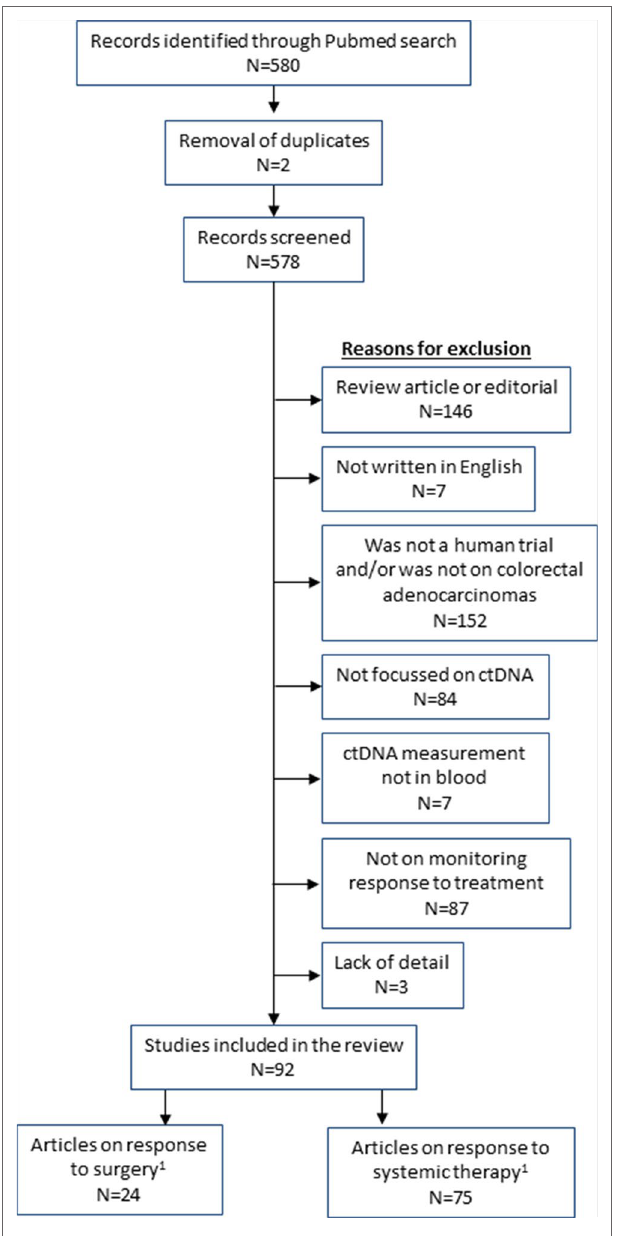
FiGURe 2 | Some of the different applications of ctDNA during treatment of colorectal